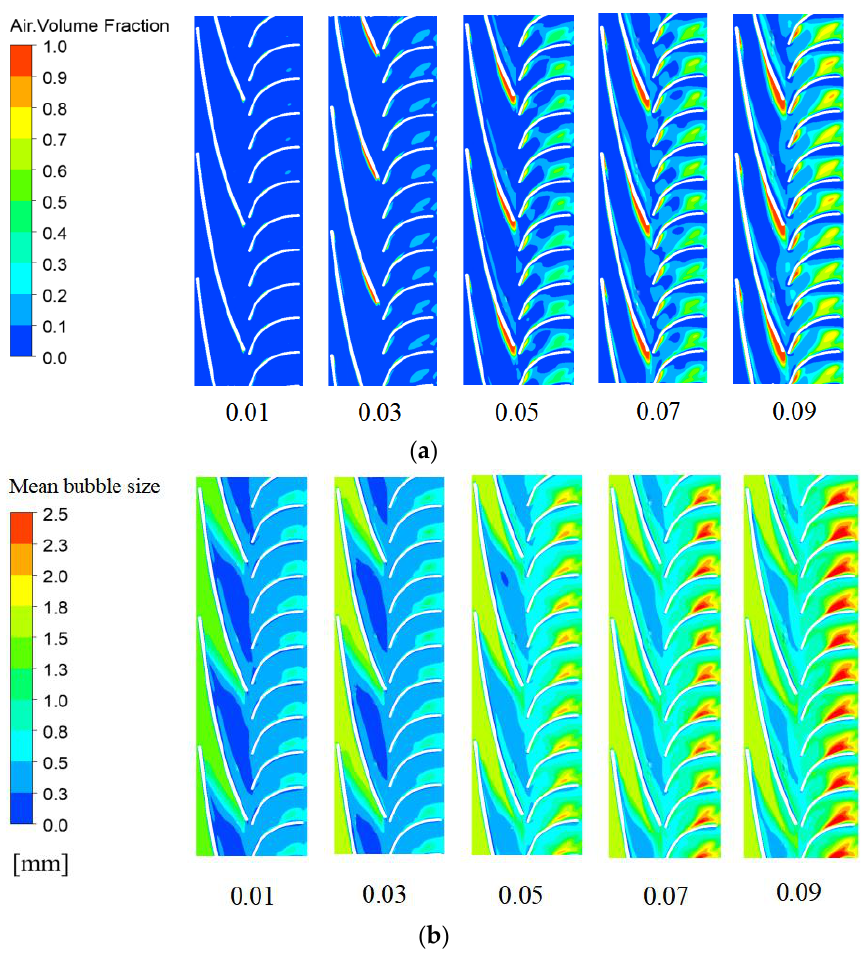
Figure 11. Circumferential gas-phase volume fraction and bubble size distribution of the pressurization unit of the multiphase pump under different IGVF conditions for gas – liquid two-phase media. ( a ) Gas phase volume fraction. ( b )Mean bubble size.